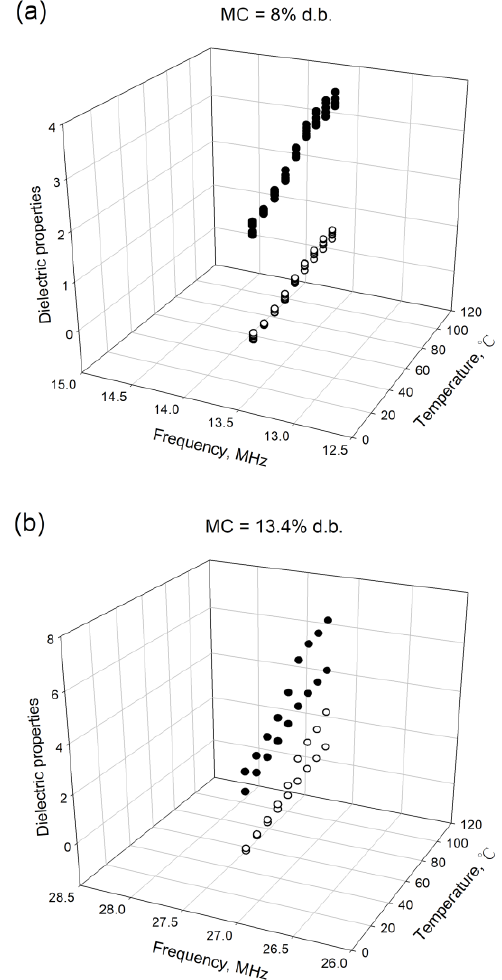
Figure 1. The dielectric properties of the egg white powder at 8.0% moisture content (MC) ( a ) and 13.4% d.b. moisture content (MC) ( b ); ○ is the dielectric constant; ● is the loss factor.